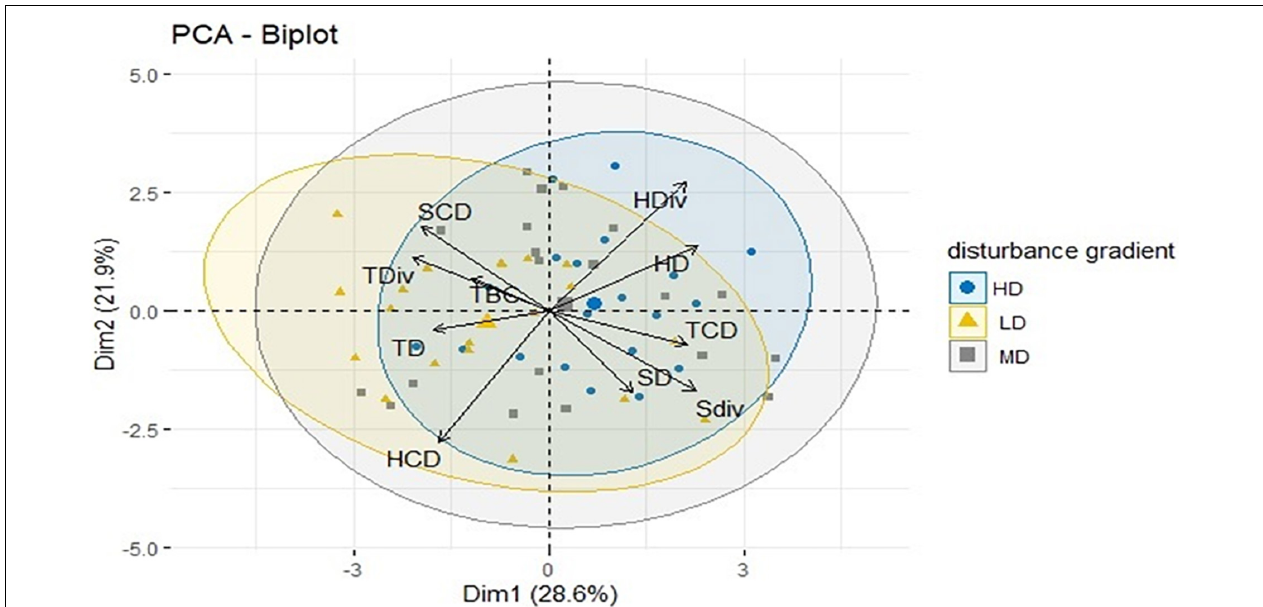
FIGURE 4 | Principal Component Analysis (PCA) bipole plot of different diversity parameters at high, medium, and low disturb home garden. TD = Tree density; TDiv = Tree diversity; TBC = Tree basal cover; TCD = Tree concentration of dominances; SD = Shrubs density; SDiv = Shrubs diversity; SCD = Shrubs concentration of dominance; HD = Herbs density; HDiv = Herbs diversity; HCD = Herbs concentration of dominance.